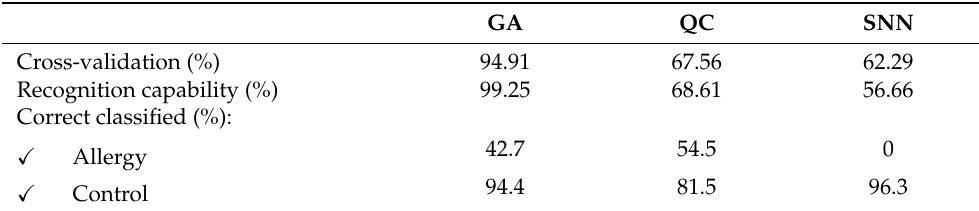
Table 3. Chemometric parameters for genetic algorithm (GA), quick classifier (QC) and supervised neural network (SNN).